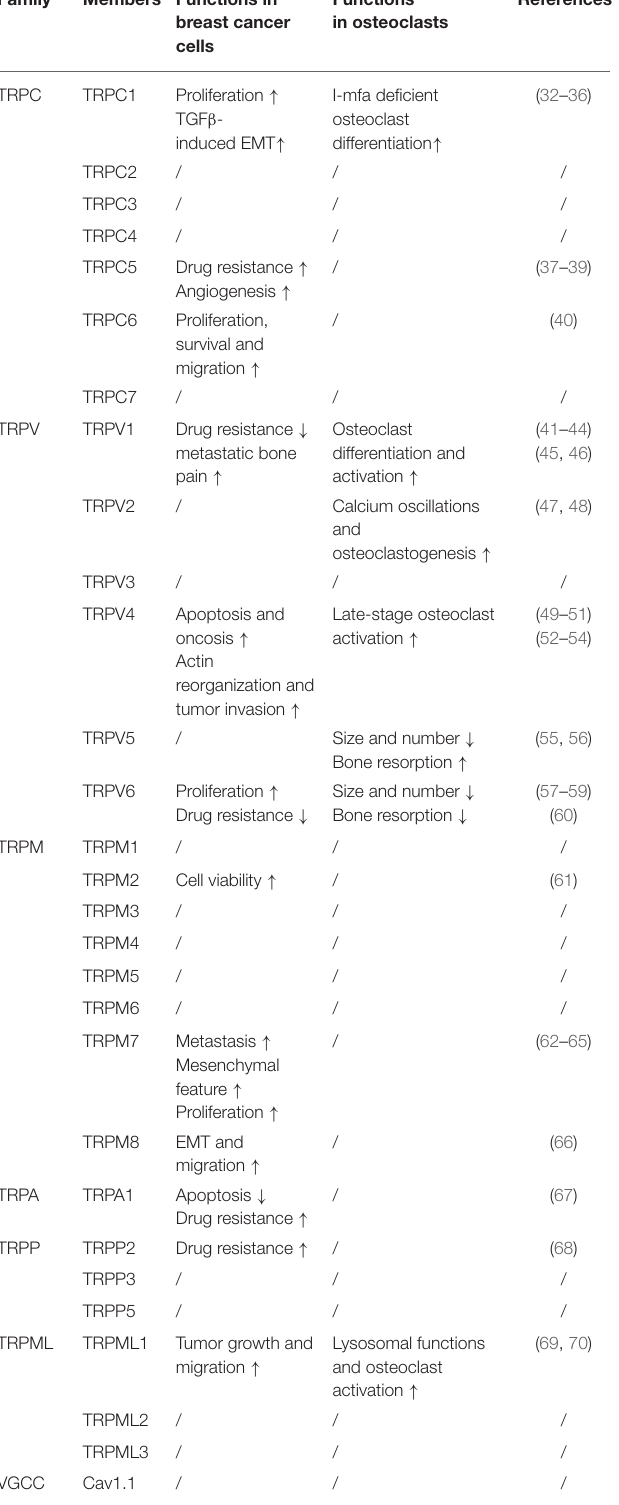
TABLE 1 | Mammalian calcium channels and their functions in breast cancer cells and osteoclasts.